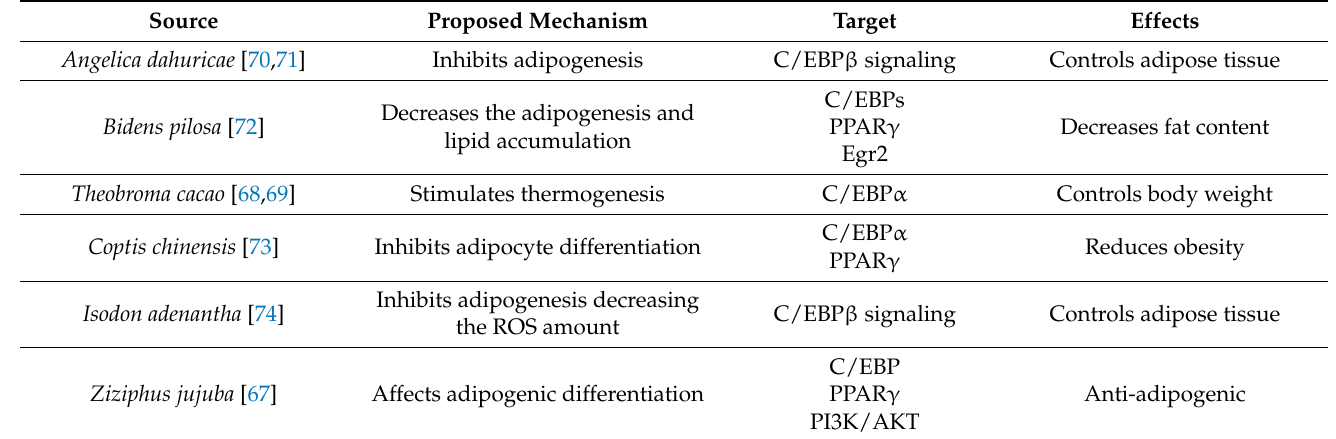
Table 4. Herbs containing nutraceuticals acting on C/EBP pathway.